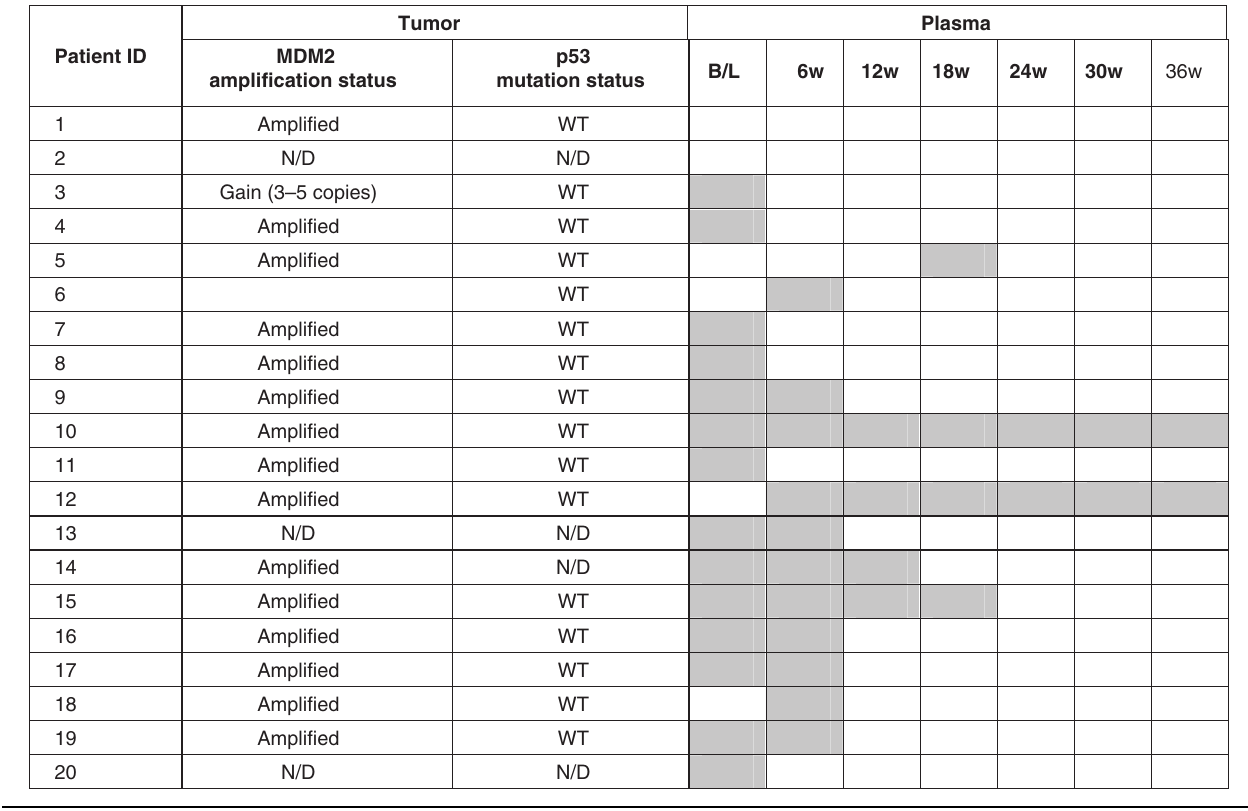
Table 1 | Baseline tumour MDM2 and TP53 genetic status and plasma collection matrix in patients with DDLPS treated with